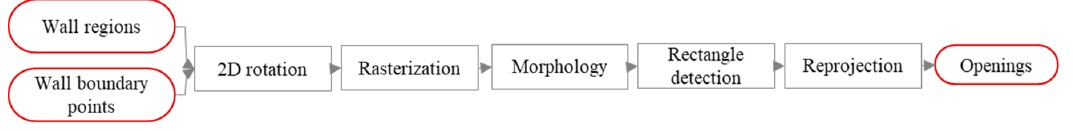
Figure 2. Workflow of the opening detection process.